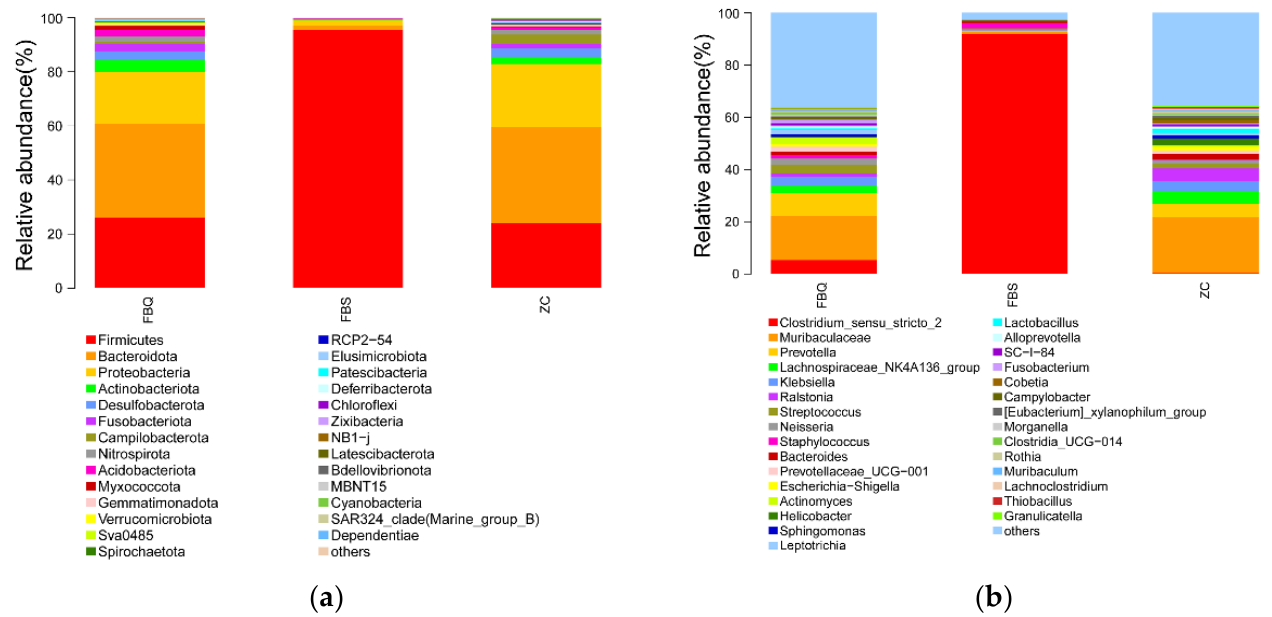
Figure 2. Relative abundance of bacterial community proportions at the phylum ( a ) and genus ( b ) levels in Mianning ham. Different colors represent different bacterial communities, and the size of the color area represents the relative abundance (percentage) of bacterial community at the phylum ( a ) and genus ( b ).